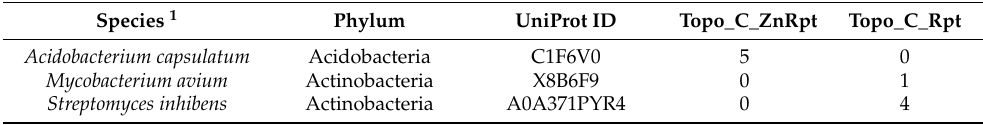
Table 2. Examples of species with the different combinations of repeated units of Topo_C_ZnRpt and in topoisomerase I (TopA) of the species are shown